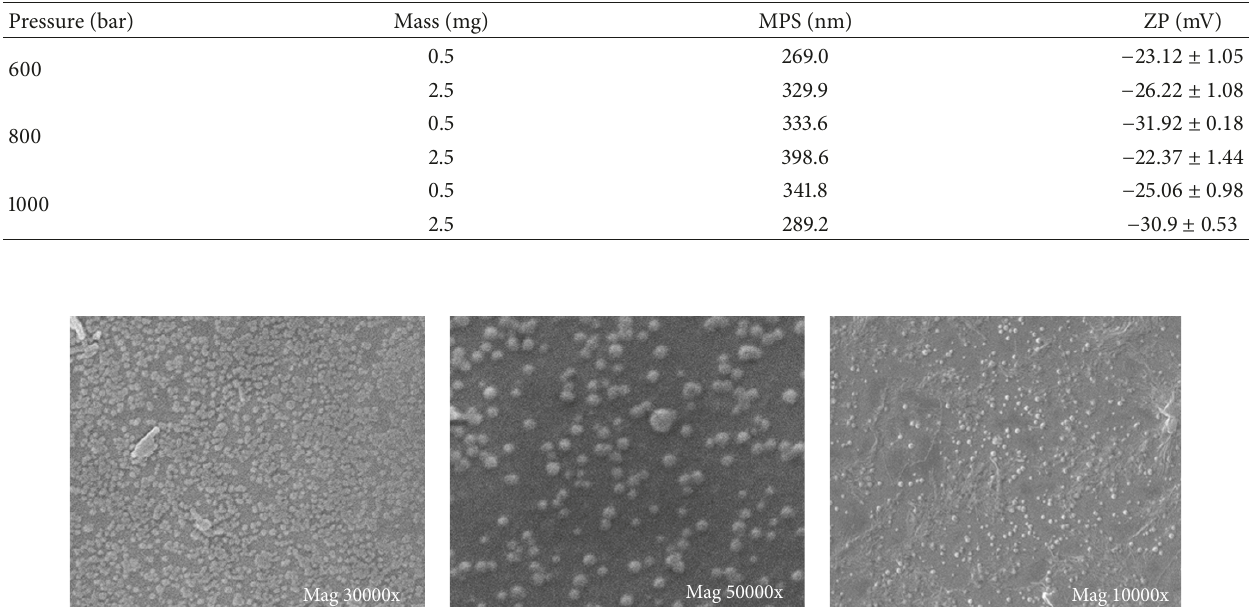
Table 4: Preparation of HCPTNPs with sodium taurocholate by HPH.